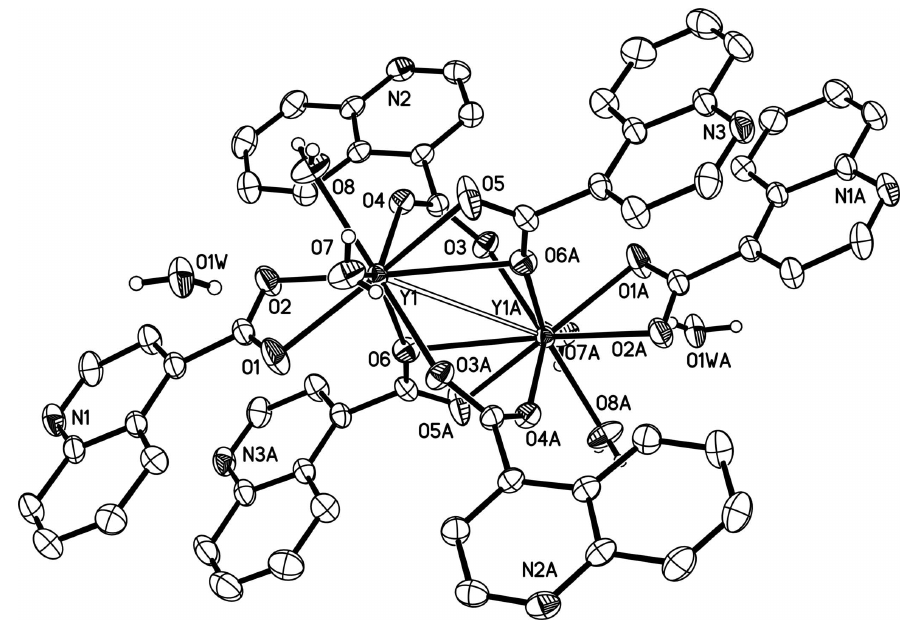
Figure 1 The molecular structure of complex (I), with displacement ellipsoids drawn at the 30% probability level (C-bound H- atoms have been removed for clarity; Symmetry code: (A) - x + 1, - y + 2, - z + 2]) Tetraaquahexakis( µ -quinoline-4-carboxylato)diyttrium(III) dihydrate 2 Crystal